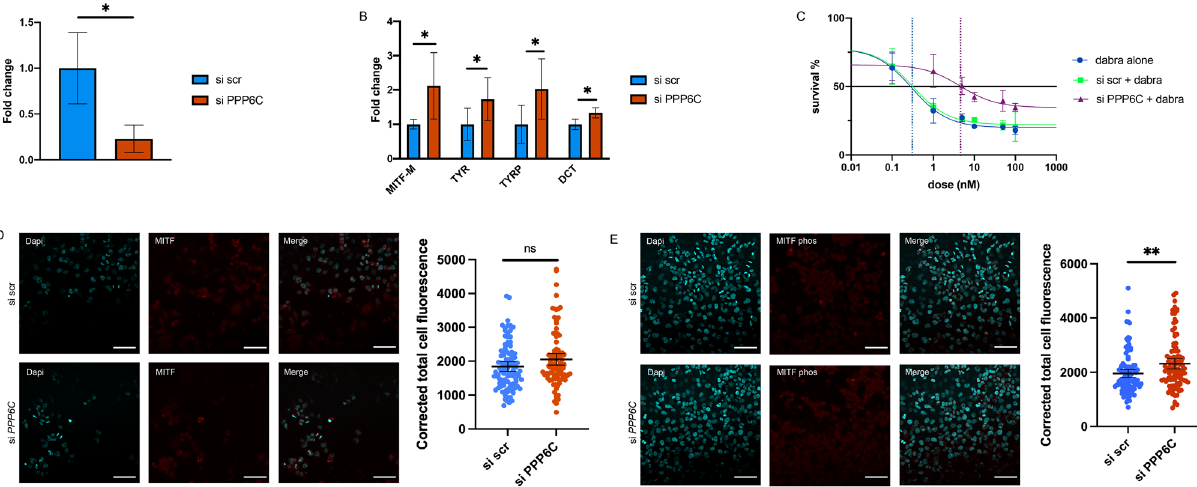
Figure 6. PPP6C expression affects MITF expression and drug resistance in melanoma. ( A ) Real-time PCR measurement of PPP6C in cells 72 h after transfection with either siPPP6C or siNon-targeting (Student’s two- tailed t-test). ( B ) Real-time PCR measurement of MITF and three target genes in cells with and without PPP6C knockdown 72 h after transfection (Student’s two-tailed t-test). ( C ) Drug dose response curve for A375 cells treated with dabrafenib and knockdown of PPP6C 72 h after transfection and treatment. Dotted lines display EC 50 for each condition. ( D ) Cellular expression of total MITF in A375 cells. Representative confocal images of fluorescence 72 h after transfection with either siPPP6C or siNon-targeting and staining with a MITF antibody, with quantification of fluorescence for each condition. One of two independent experiments is shown (Student’s two-tailed t-test). ( E ) Cellular expression of phospho-MITF in A375 cells. Representative confocal images of fluorescence 72 h after transfection with either siPPP6C or siNon-targeting and staining with a phospho-specific MITF antibody, with quantification of fluorescence for each condition. One of two independent experiments is shown (Student’s two-tailed t-test). p -values are indicated as following: * p < 0.05, ** p ≤ 0.01. NS: non-significant p